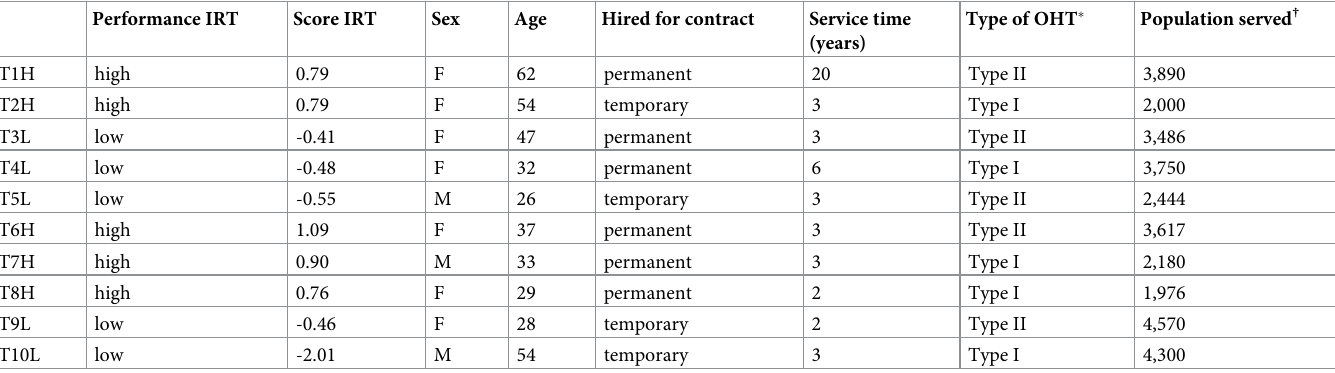
Table 2. Demographic and health service data of interviewed’